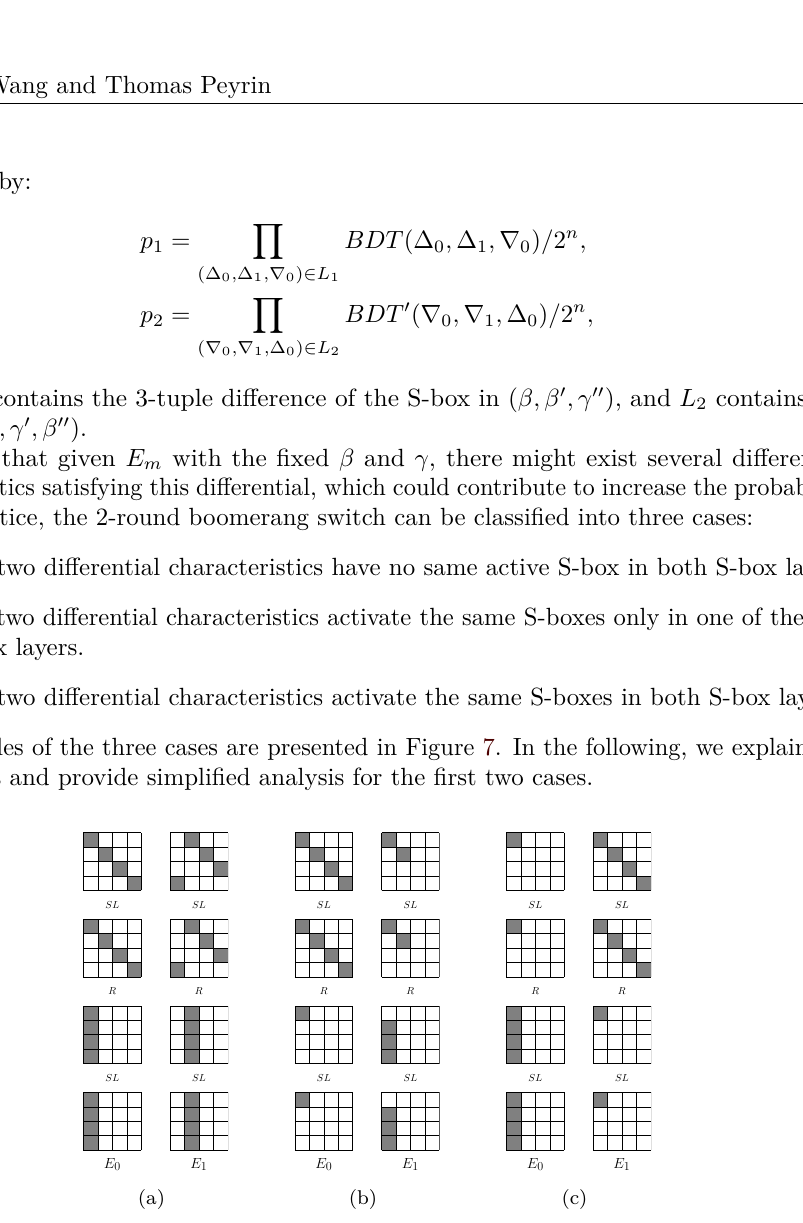
Figure 7: Examples of three cases for the boomerang switch in two rounds